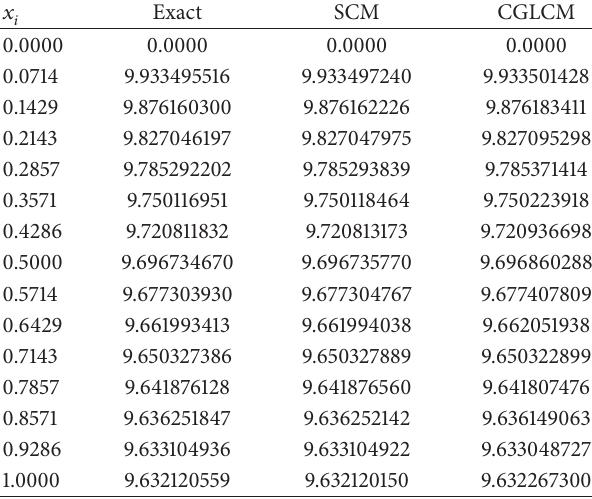
Table 1: Comparison of exact solution with numerical solutions for Problem